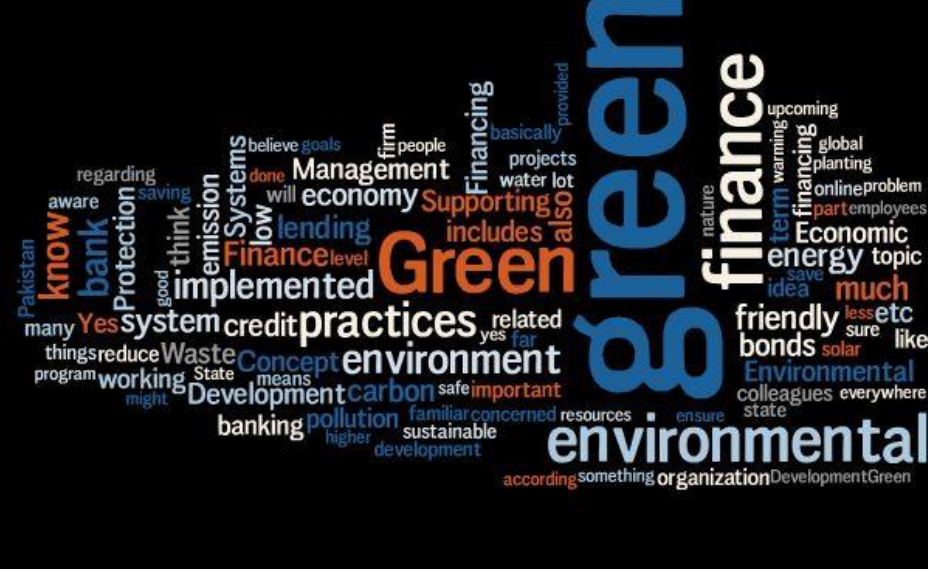
Figure 3. Impediments to Green